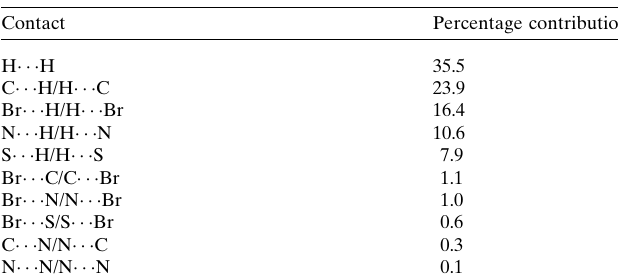
Table 2 Percentage contributions of interatomic contacts to the Hirshfeld surface for the title salt.